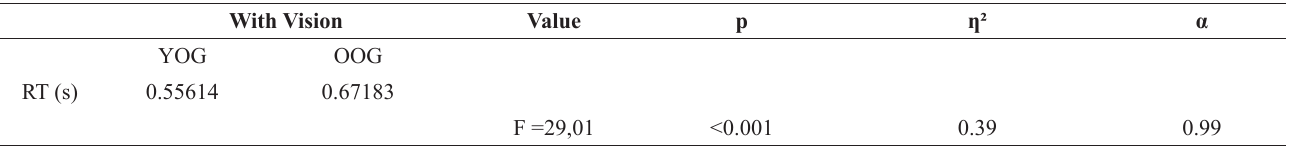
Table 2. Results of Experiment